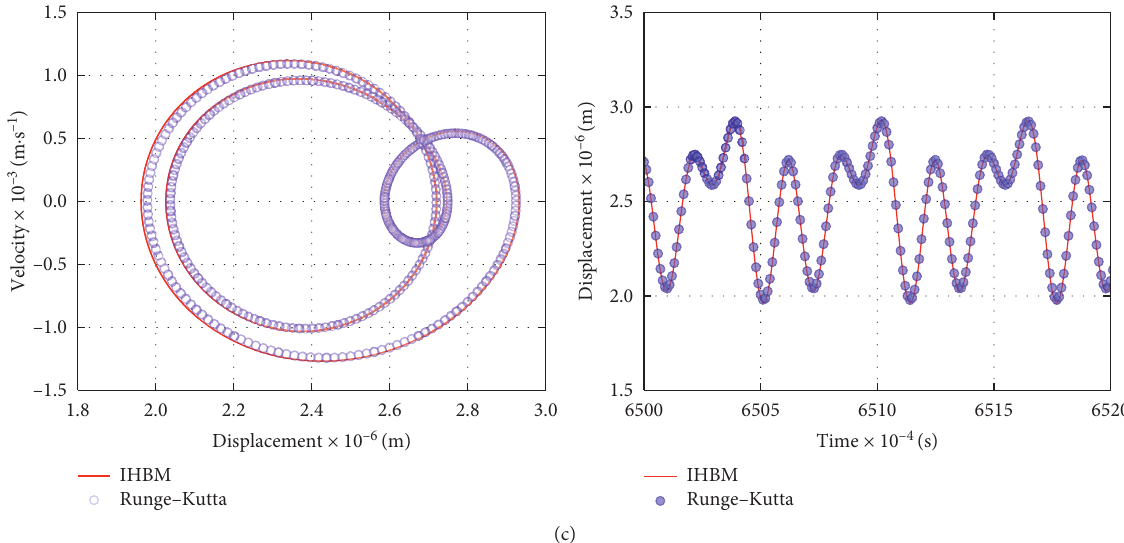
Figure 6: Phase diagram and time history diagram of the system at different frequencies. (a) Ω � 1, (b) Ω � ½, and (c) Ω �